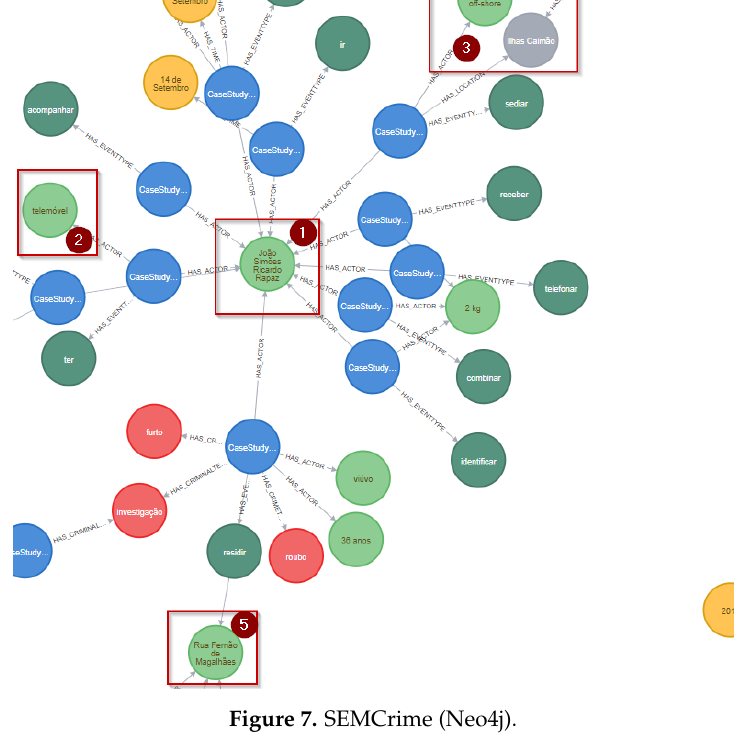
Figure 7. SEMCrime (Neo4j).